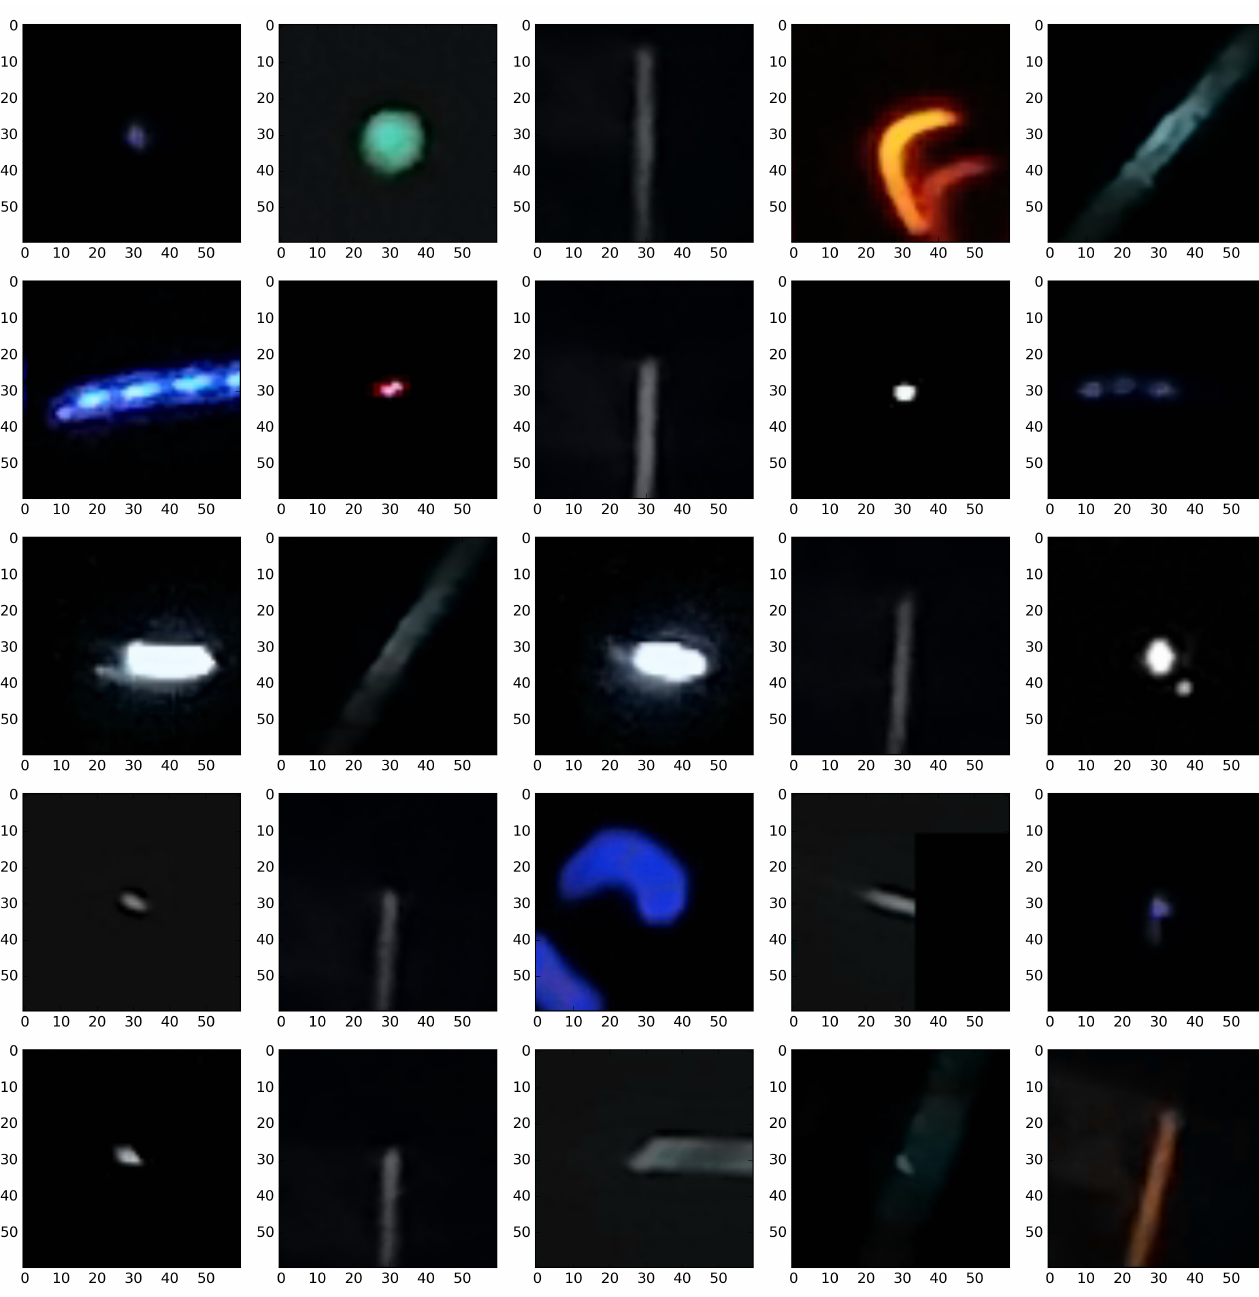
Figure 16. Classification on the selected part of original CREDO set demonstrating the artefact class. An example of the performance of a classifier based on a dimension 2 input tensor composed of the greyscale image and a D2